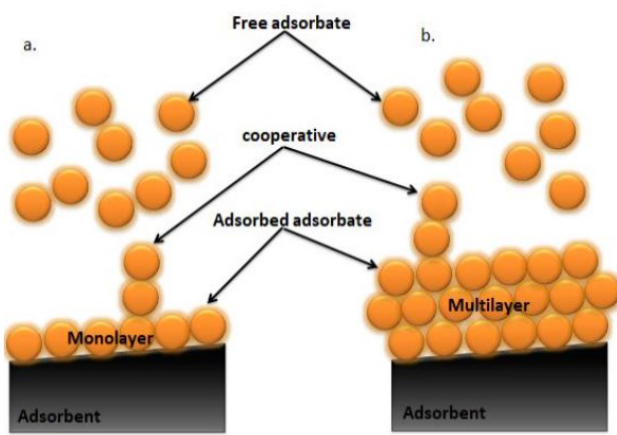
Fig. 3. Mechanism illustration of the interaction of adsorbate and adsorbent during the adsorption process. The interaction can be formed as a monolayer (a) and multilayer (b). The figure has been adopted from the